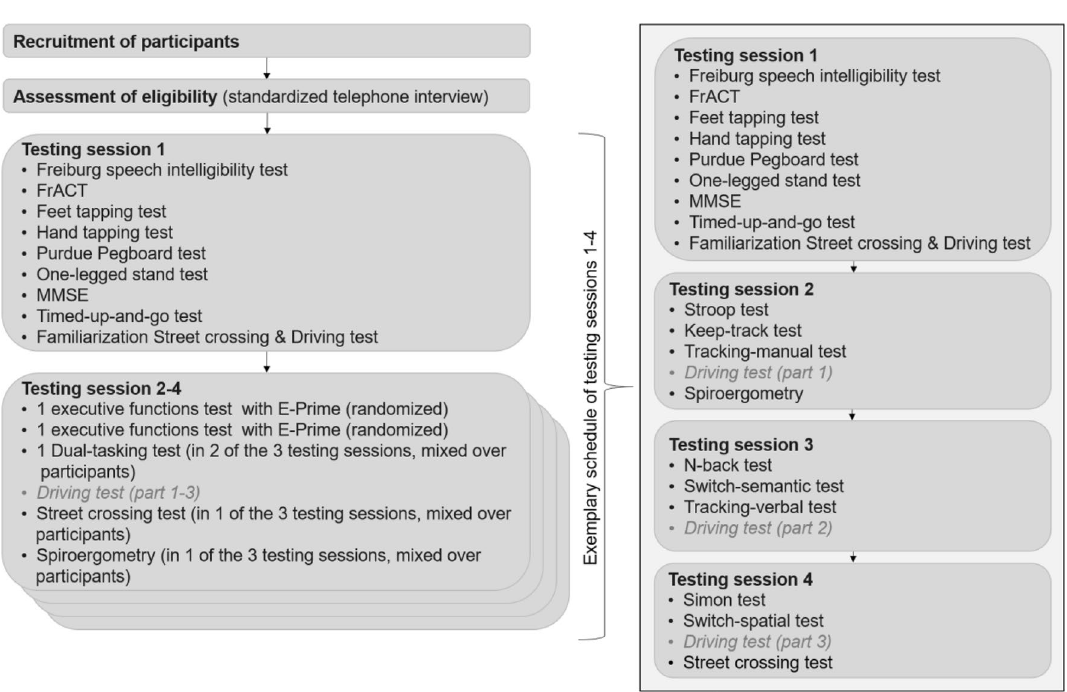
Figure 4. Overview of the assessment of executive functions, motor coordinative and cardiovascular fitness as well as the different components of cognitive-motor multitasking.